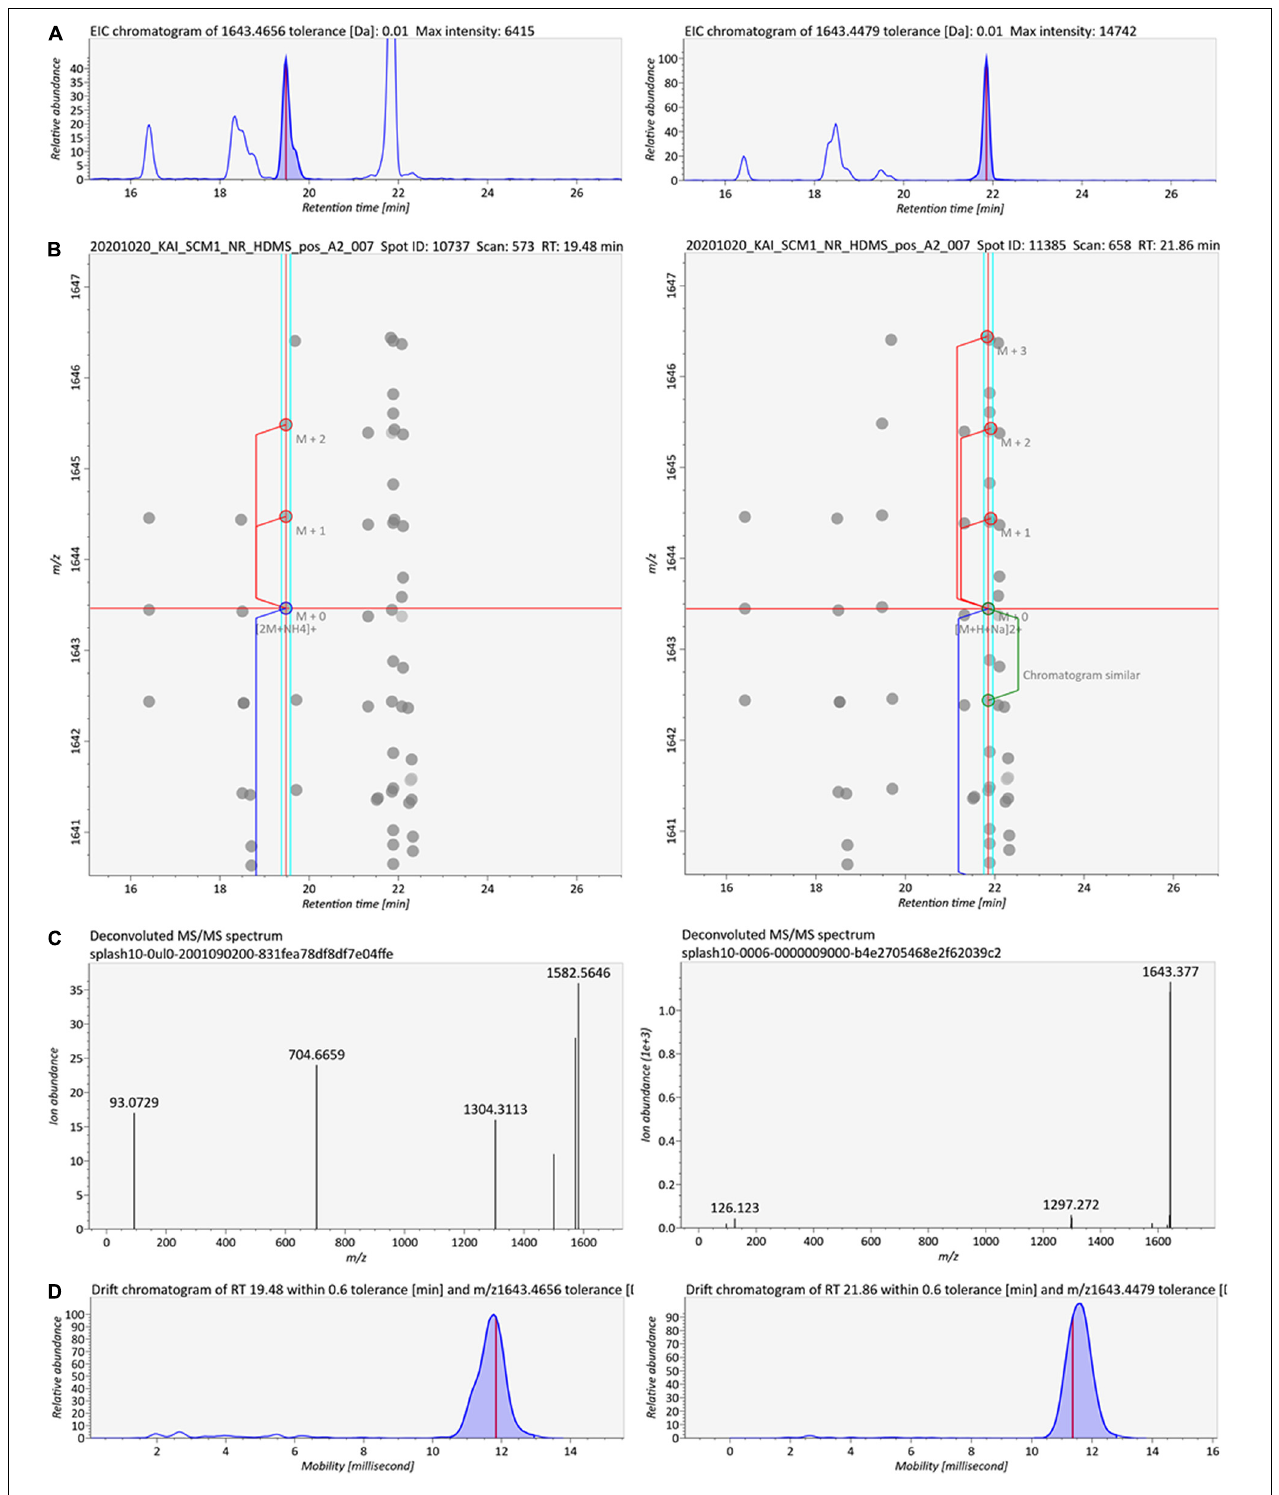
FIGURE 11 | Spectral characteristics of the 2G-GDGT-0 type I and II structural isomers ([M + NH 4 ] + ). (A) EICs of the structural isomers that were eluted 2 min apart, (B) deconvolution of the spectral features and isotopic ions, (C) deconvoluted MS 2 spectra of the isomers, and (D) ion mobility spectra of the isomers.